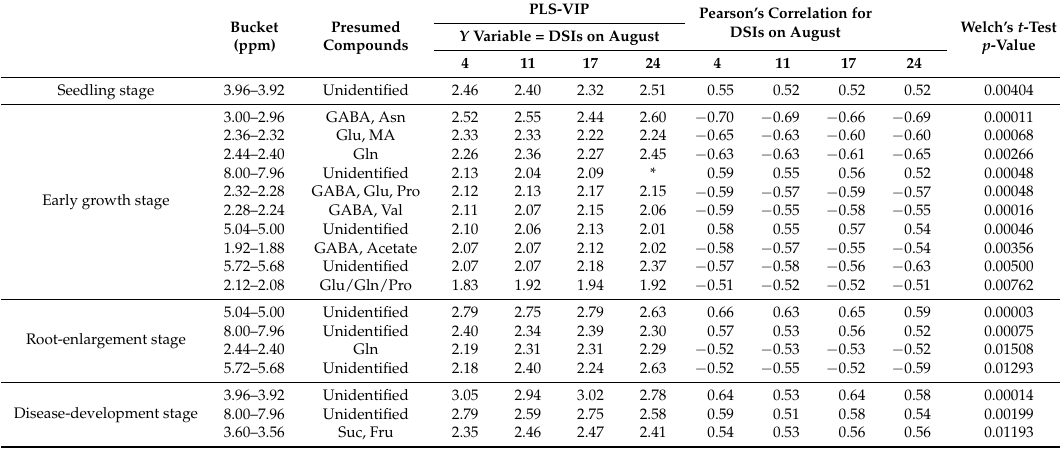
DSIs on August Welch’s t -Test